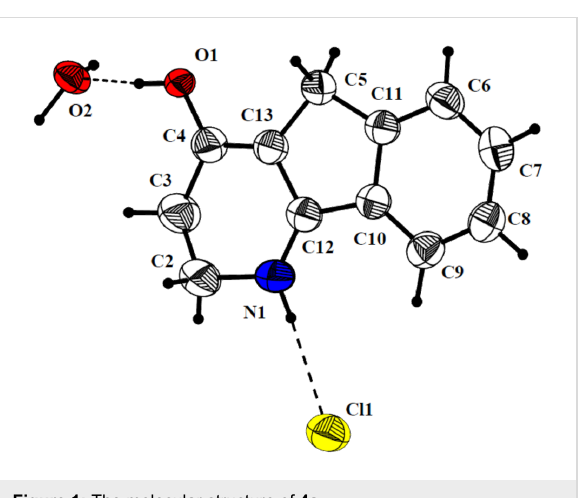
Figure 1: The molecular structure of 4a .